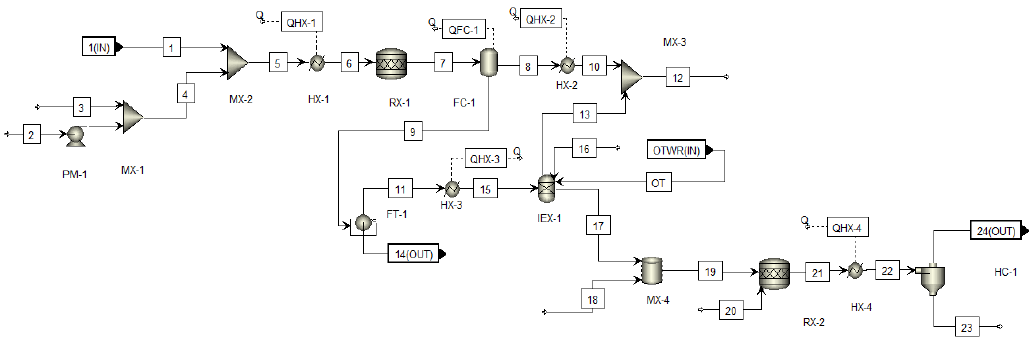
Figure 2. Pretreatment stage flowsheet in topology 1.